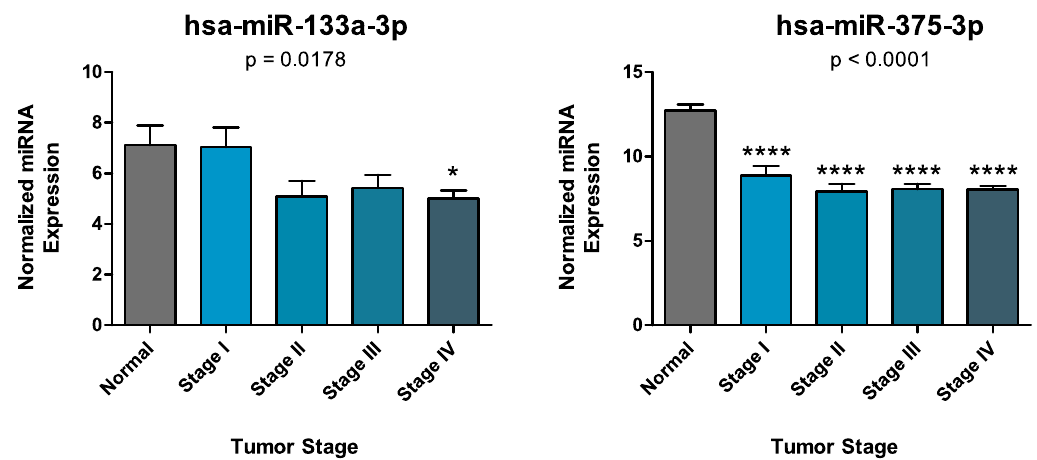
Figure 5. Panel ( A ) Statistical di ff erence of hsa-miR-133a-3p expression in normal individuals and di ff erent tumor stages according to the TCGA HNSC data ( p = 0.0178); Panel ( B ) Statistical di ff erence of hsa-miR-375-3p expression in normal individuals and di ff erent tumor stages according to the TCGA HNSC data ( p < 0.0001). *: p < 0.05; ****: p < 0.0001.